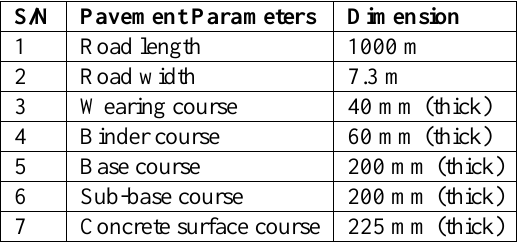
Table 1: Parameters considered for the LCCA.